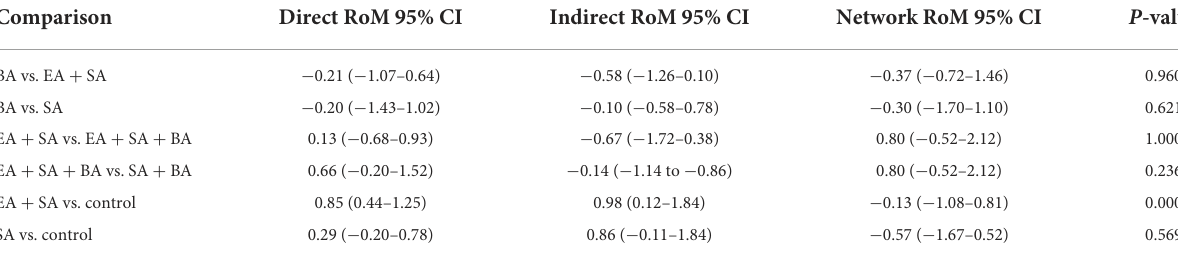
TABLE 5 Node-splitting analysis of inconsistency (living